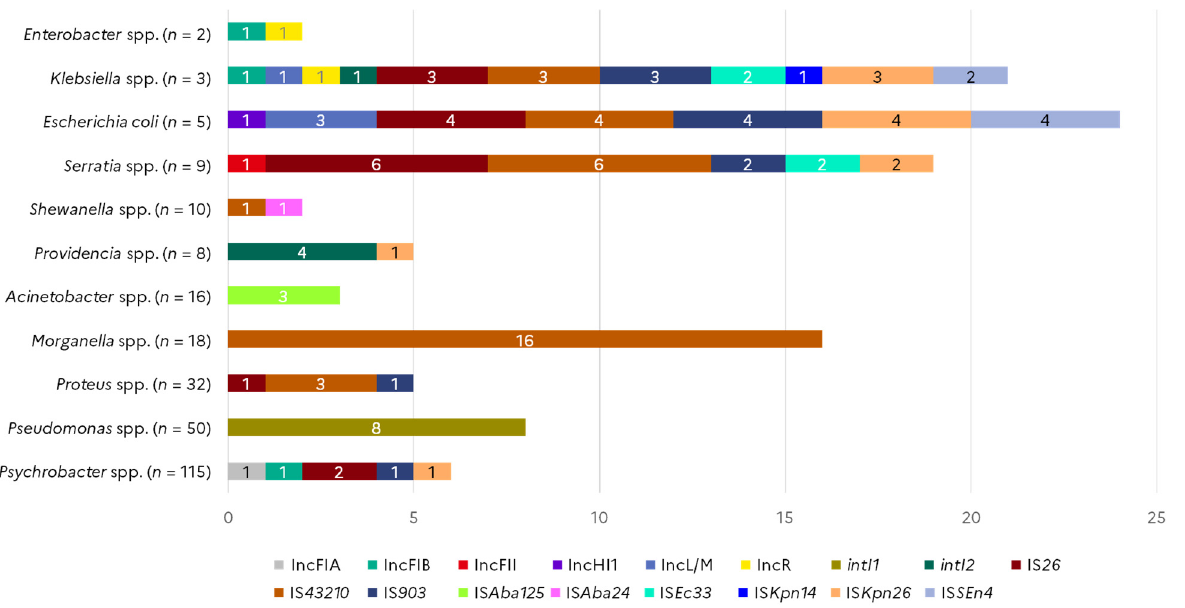
Figure 3. Occurrence of mobile genetic element markers in Gram-negative isolates from seafood ( N = 268) .